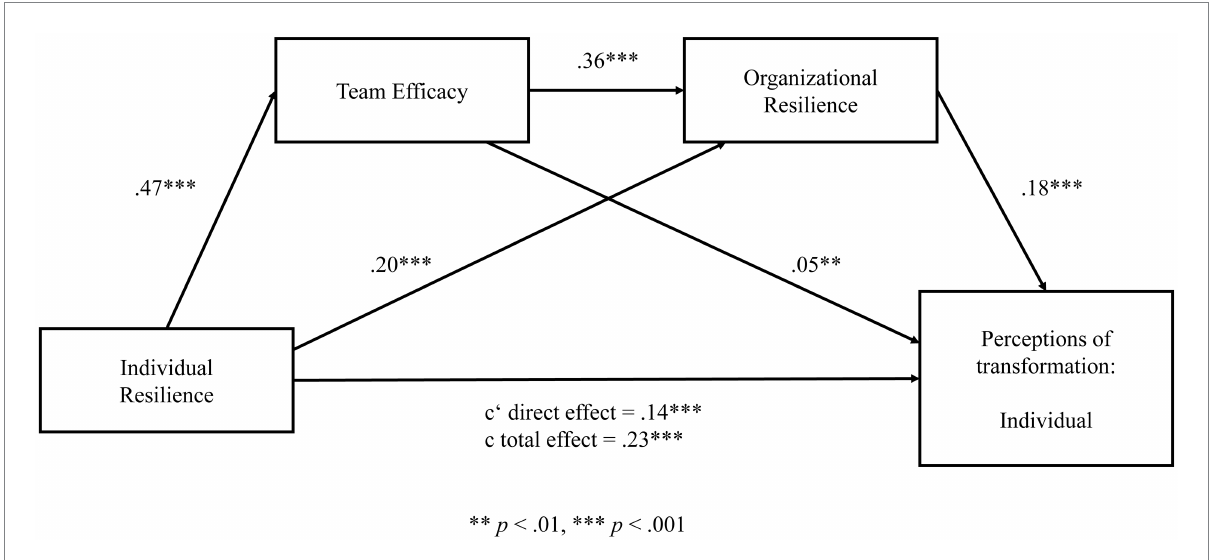
FIGURE 2 Sequential mediation model for perceptions of transformation on the individual level. Significant at level ** p < 0.01, *** p <